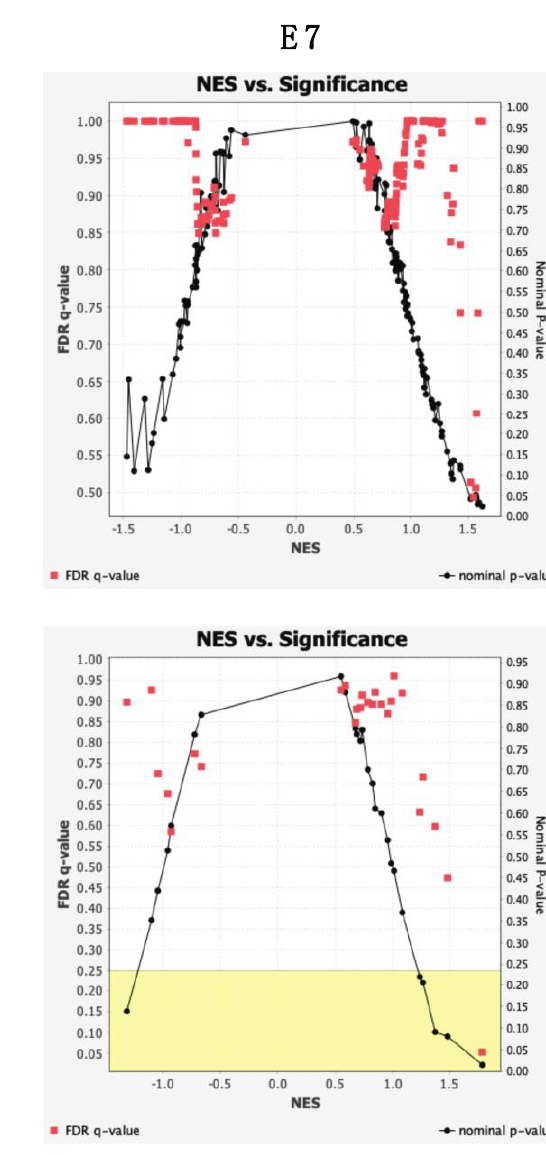
Figure 6. Oncogenic and telomeric signaling pathway significance. Significance curves of oncogenic and telomeric gene sets enriched in samples of E6/E7 high expression and low expression. Nominal enrichment scores (NESs) describe the extent of which gene sets are dysregulated across cohorts. Corresponding nominal p-values and FDR q-values are shown, with p -value < 0.05 and q-value < 0.25 (yellow) used as significance thresholds. Patients were categorized by individual E6/E7 TPM , with TPM ≥ 10 considered high expression, and TPM < 10 low expression.